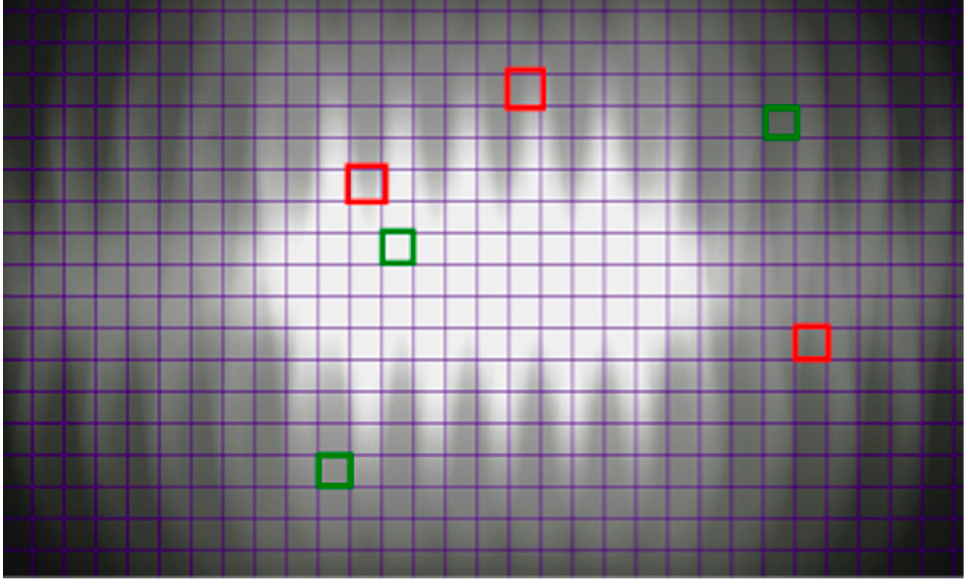
Figure 8. Experimental setup used to measure gloss data, using a wired grid with cells of 30 × 30 mm 2 , where each gloss measurement takes place.